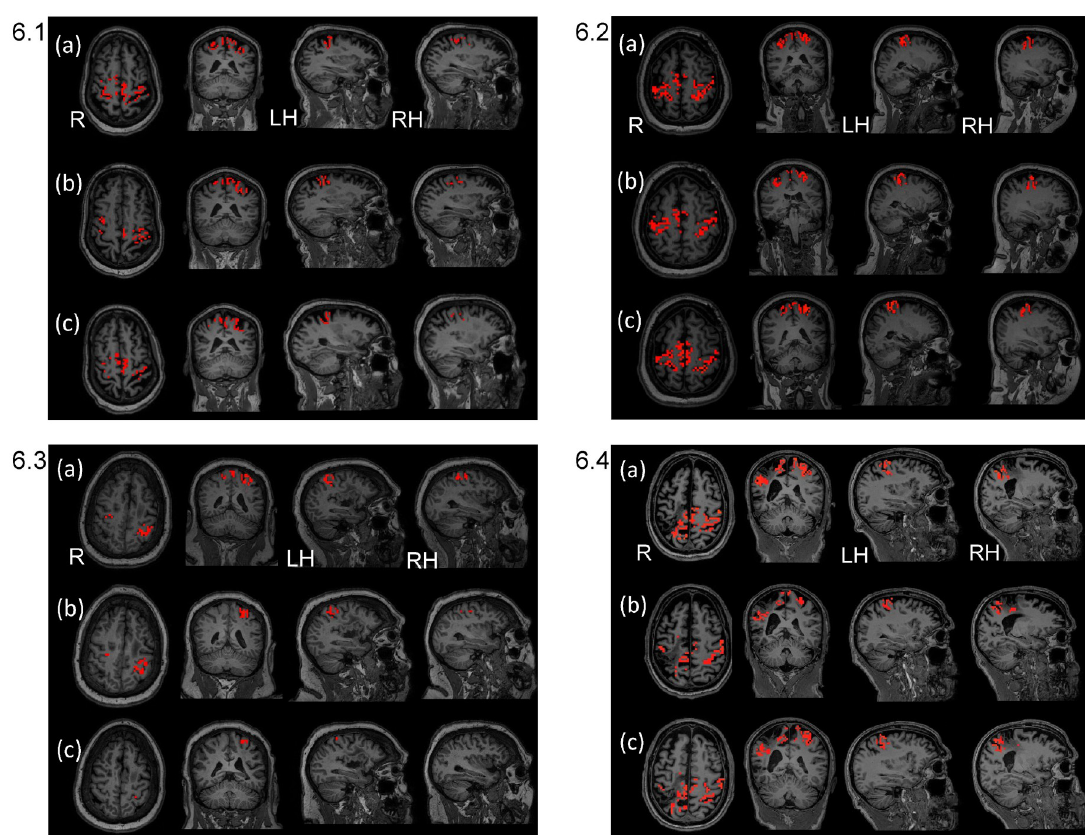
Fig 6. Brain maps across three neural feedback training sessions (rows a, b, and c from sessions 1, 2, and 3, respectively) using real time fMRI (rt-fMRI) for each of four cases (6.1, 6.2, 6.3., and 6.4, respectively). Brain maps show functional magnetic resonance imaging (fMRI) data acquired during each of the three real-time fMRI neural feedback wrist coordination training sessions. A session- specific, t-statistic map was overlaid on the session-specific T1 anatomical image. We used a significance threshold of p < 0.05 with small volume family-wise error correction for each ROI. 6.1. for S1. Brain maps for the left lesioned hemisphere reflect small changes ( � 10%) or consistent pattern comparing first to last of the three sessions, rows a and c. The right hemisphere showed a marked lessening of activation (19%–62% decreases; details contained in Table 3a, S1 File). 6.2. for S2. Brain maps for the left lesioned hemisphere reflect a consistent pattern of activation comparing first to last of the sessions, rows a and c, for Hand Knob and premotor, and a lessening of activation in Primary Motor-Hand Knob and sensory. The right hemisphere showed a similar pattern across the three sessions, with the exception of a 10% increase in Primary Motor-Hand Knob (details in Table 3b, S1 File). 6.3. for S3. Brain maps reflect a marked lessening of activation comparing the first and last of the three sessions for the left lesioned hemisphere (29% to 59%) and the right hemisphere (11%–56%; details in Table 3c, S1 File). 6.4. for S4. Brain maps reflect lessening of activation comparing the first and last of the three sessions, rows a and c for right lesioned hemisphere ( � 10%) except for Hand Knob remaining constant. The left hemisphere showed lessening of activation (7%-41%), except for Hand Knob which remained constant; details in Table 3d, S1 File).